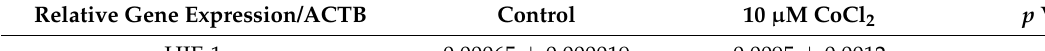
Table 4. Effect of CoCl 2 on HIF -1 α